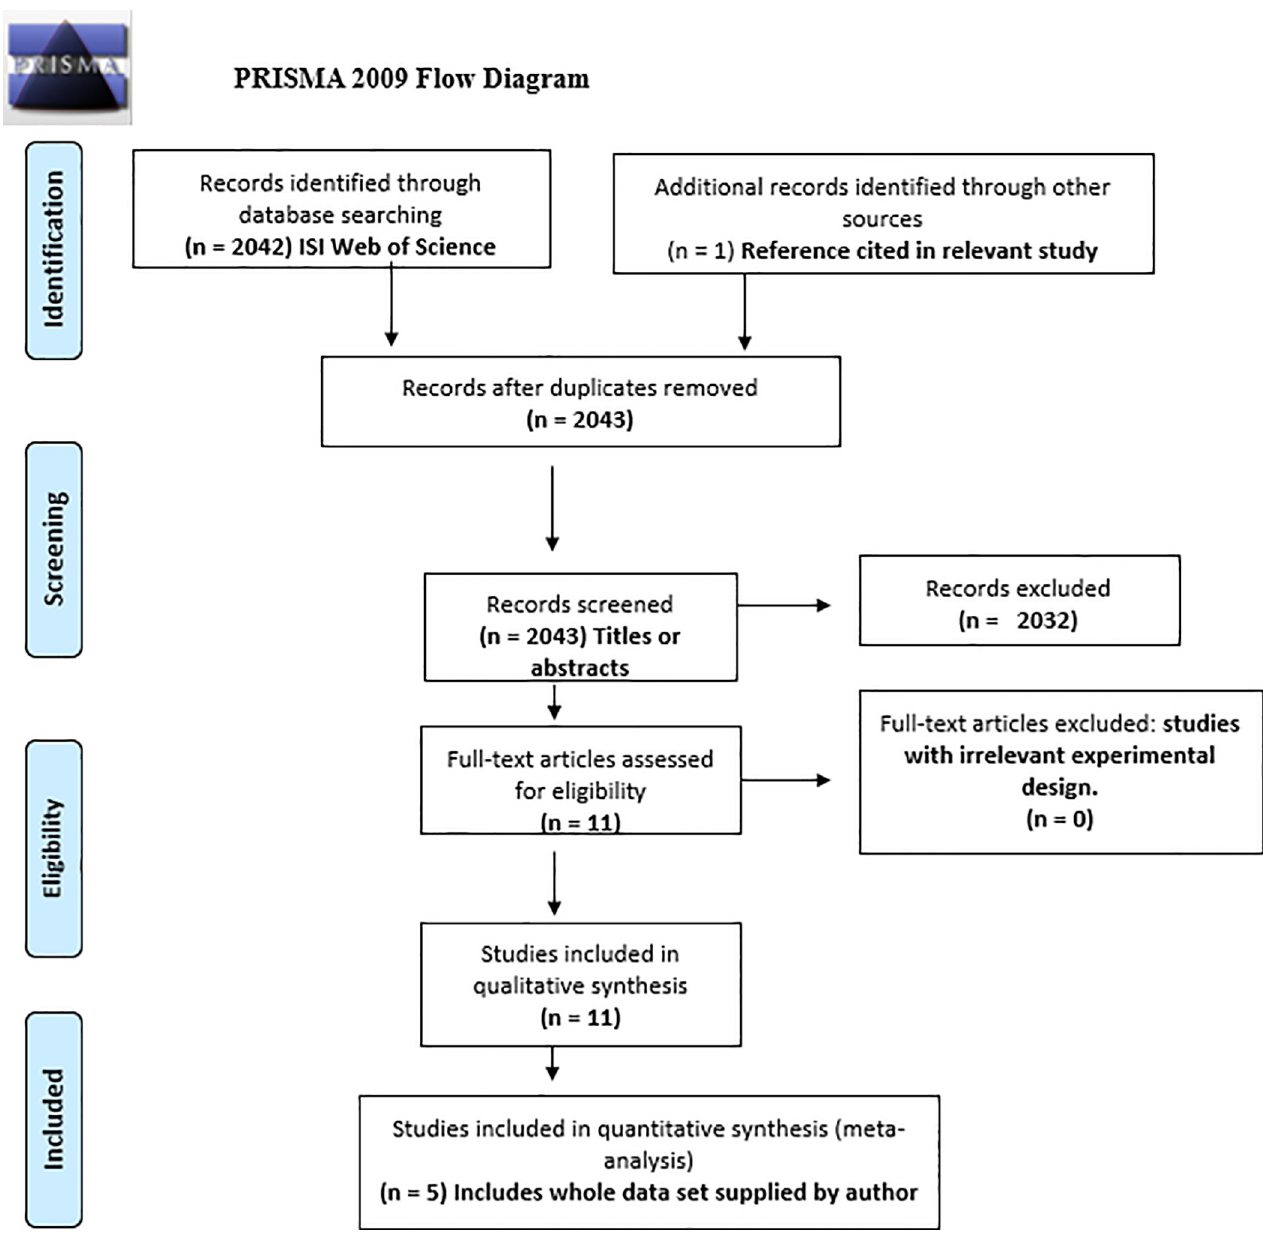
Fig 3. PRISMA flow diagram for study selection. From : Moher D, Liberati A, Tetzlaff J, Altman DG, The PRISMA Group (2009). Preferred Reporting Items for Systematic Reviews and Meta-Analyses: The PRISMA Statement. PLoS Med 6(7): e1000097. 10.1371/journal.pmed1000097. For more information, visit: www.prisma-statement.org.